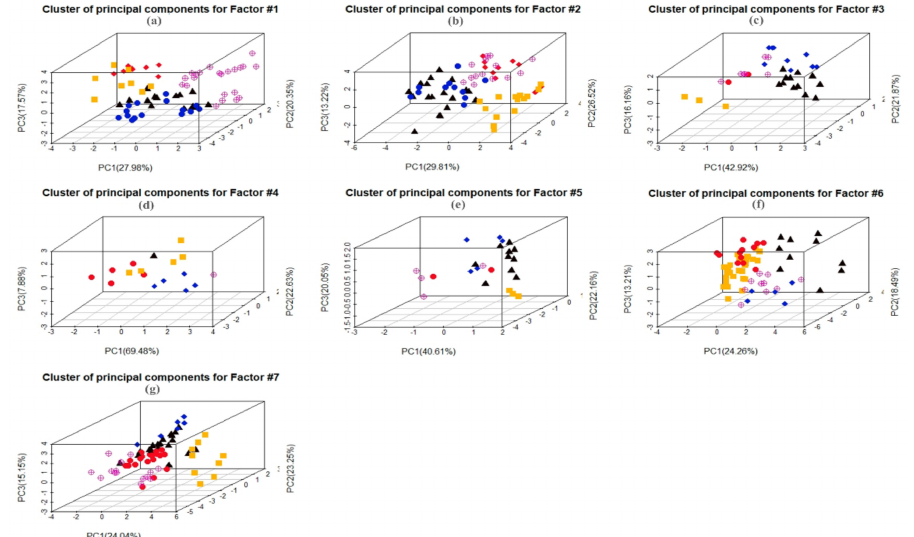
Figure A1. A cluster based on basin experts’ professions, in which black triangles are hydrologists, yellow rectangles are socioeconomics, purple crossed circles are environmentalists, red circles are political scientists, and blue diamonds are law experts, where ( a ) are experts response divisions on indicators under factor-#1—natural features, ( b ) factor-#2—socioeconomic needs of basin states, ( c ) factor-#3—the population dependent on the watercourse, ( d ) factor-#4—the e ff ects of water use, ( e )factor-#5—existing and potential uses, ( f ) factor-#6—costs of conservation & protection, and ( g ) factor-#7—availability of alternative and comparable values.